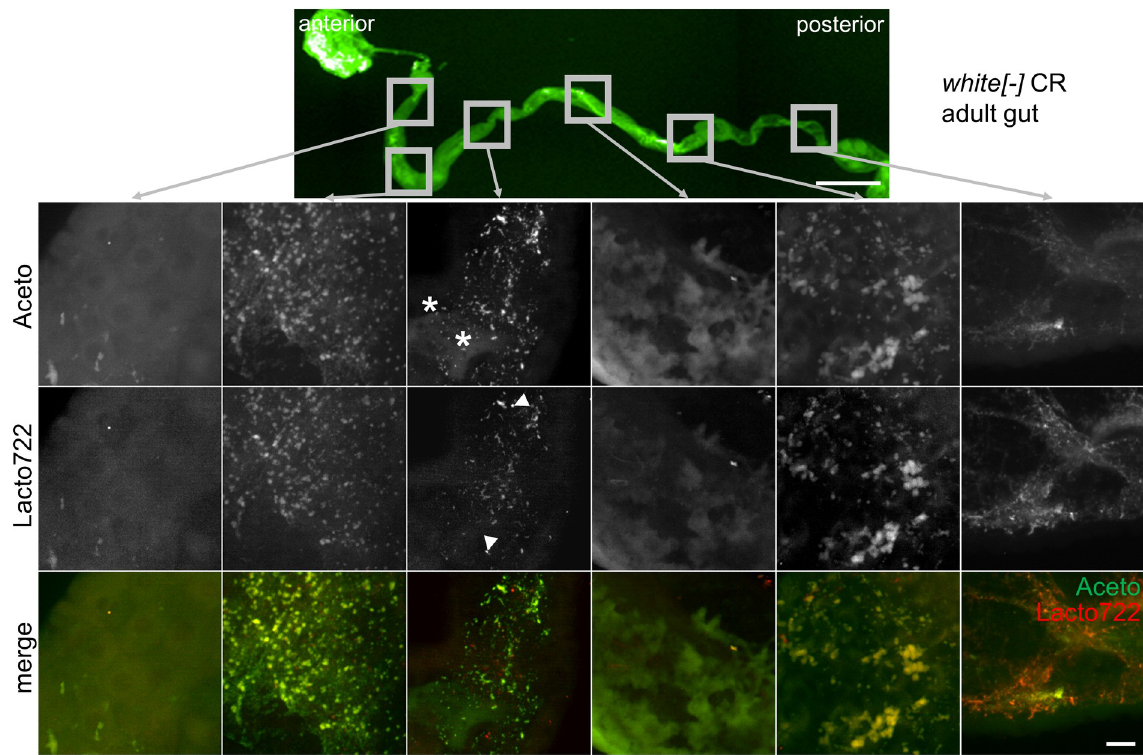
Fig 5. Fluorescence in situ hybridization of adult Drosophila guts. FISH was performed with Carnoy’s solution-fixed adult Drosophila guts using the genera-specific probes Aceto (green) and Lacto722 (red) (4 μ M/probe) and 40% formamide for 16 hours at 46˚C. Prior to hybridization, larval guts were treated with 10 mg/ml lysozyme for 15 minutes at 37˚C. An overview of the entire gut was imaged and detailed zoom-ins of six different regions are shown. The figure shows representative examples from at least three separate experiments. Exemplary Acetobacter cells are marked with asterisks and Lactobacillus cells are indicated by arrowheads. In each experiment 5 to 10 guts per condition were dissected. Scalebars represent 500 μ m (overview) and 10 μ m (zoom-ins).